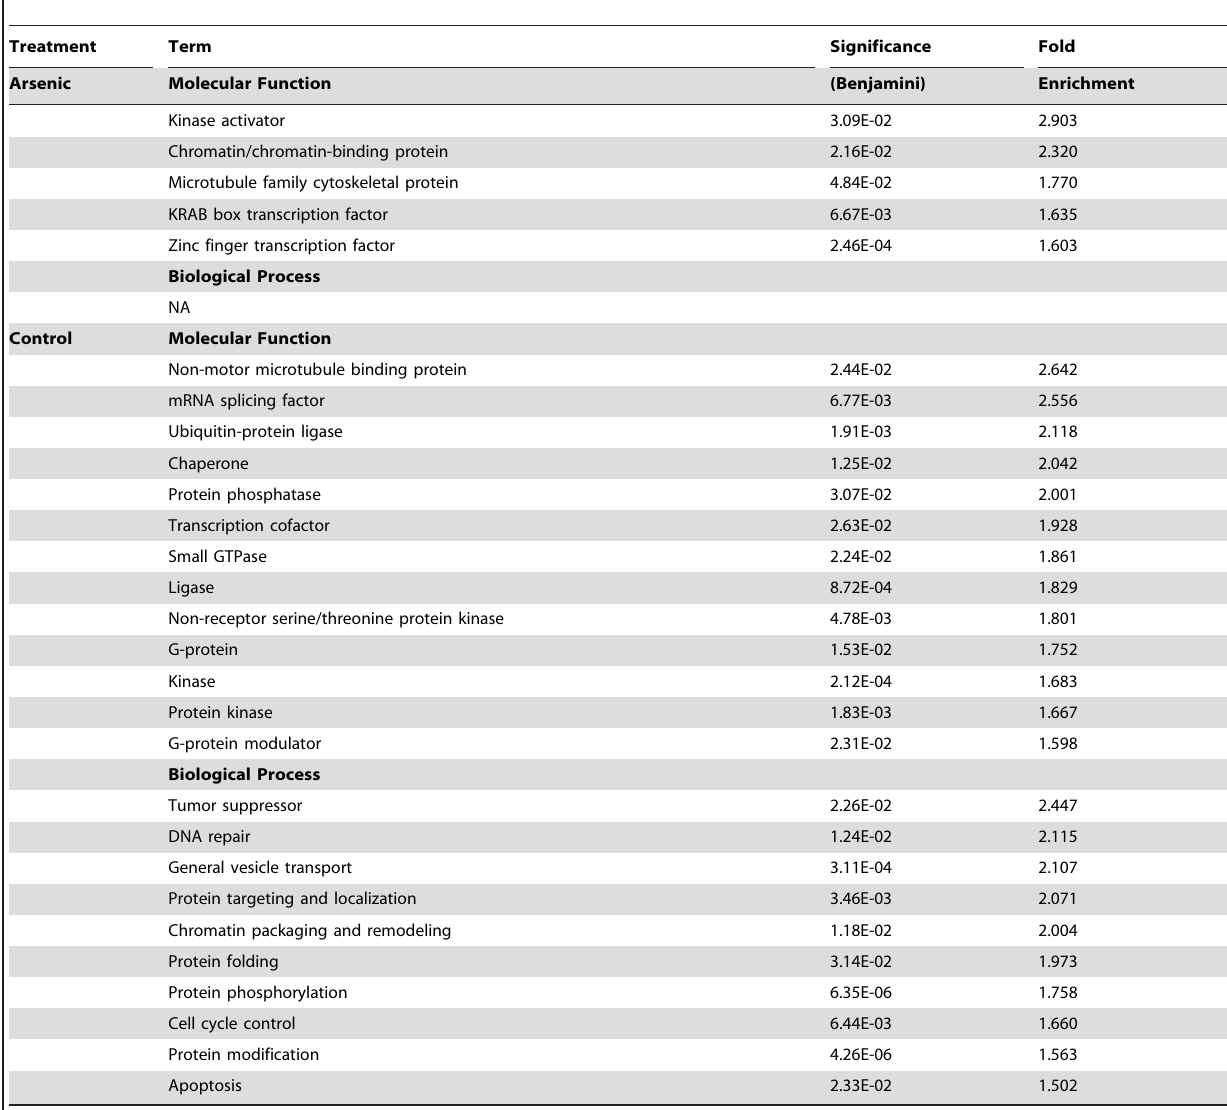
Table 1. Unique functional annotation clusters of genes from arsenic and control